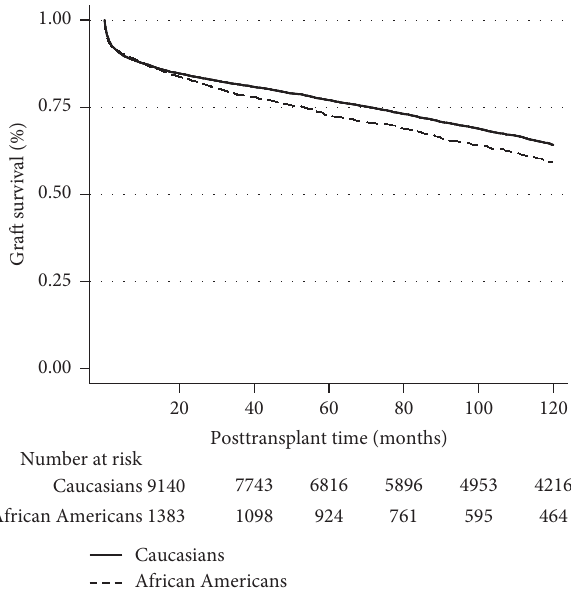
Figure 2: Unadjusted Kaplan–Meier estimates comparing graft survival (composite of posttransplant death and retransplant by race). Table 4: Multivariate Cox proportional hazards model for graft survival.